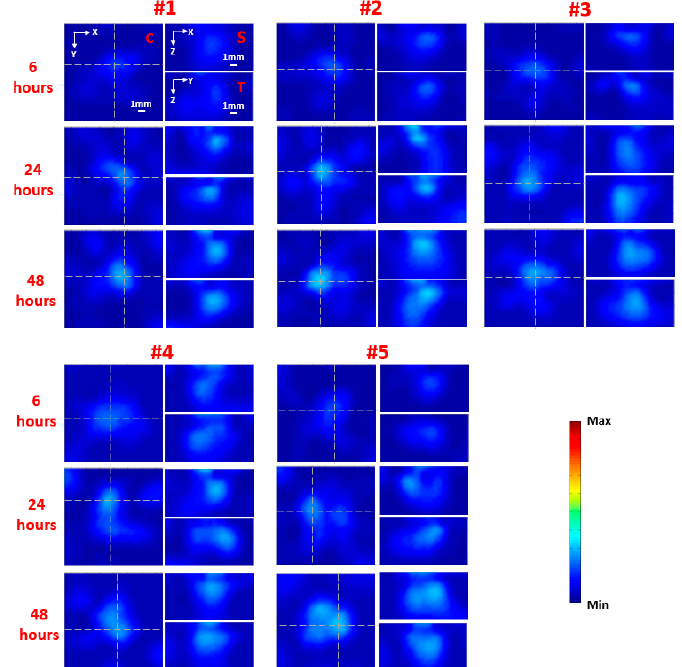
Figure 3. Reconstructed fluorescence molecular tomography (FMT) images along representative coronal (C), sagittal (S), and transverse (T) planes for the five mice from the nontargeted (nontargeted NIR 830) group at 6, 24, and 48 h post injection of nanoprobes. The C slice is indicated in the first image for mouse #1 (upper left), while the S and T slices are also noted in the other two images in the first set of images for mouse #1, which are given along the white dashed lines that are crossing the center of the tumor in the coronal image.